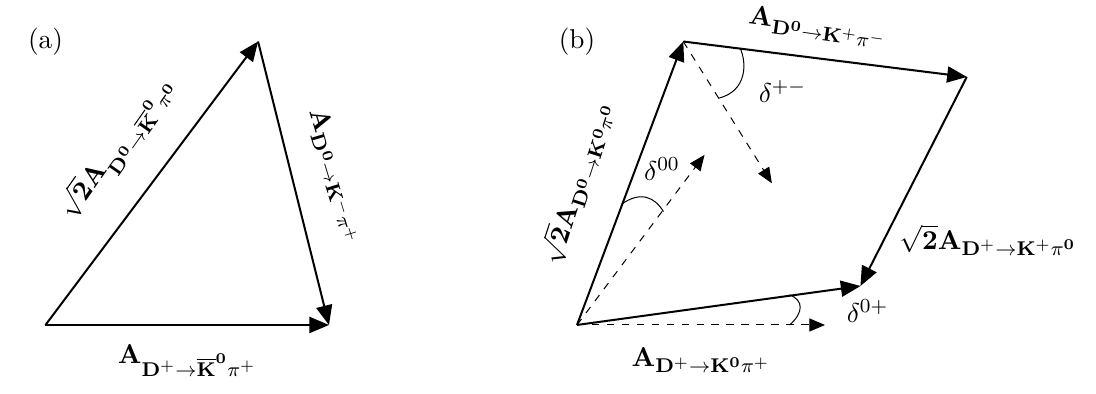
Figure 1 . SU f (3) sum rules for CF (a) and DCS (b) decay